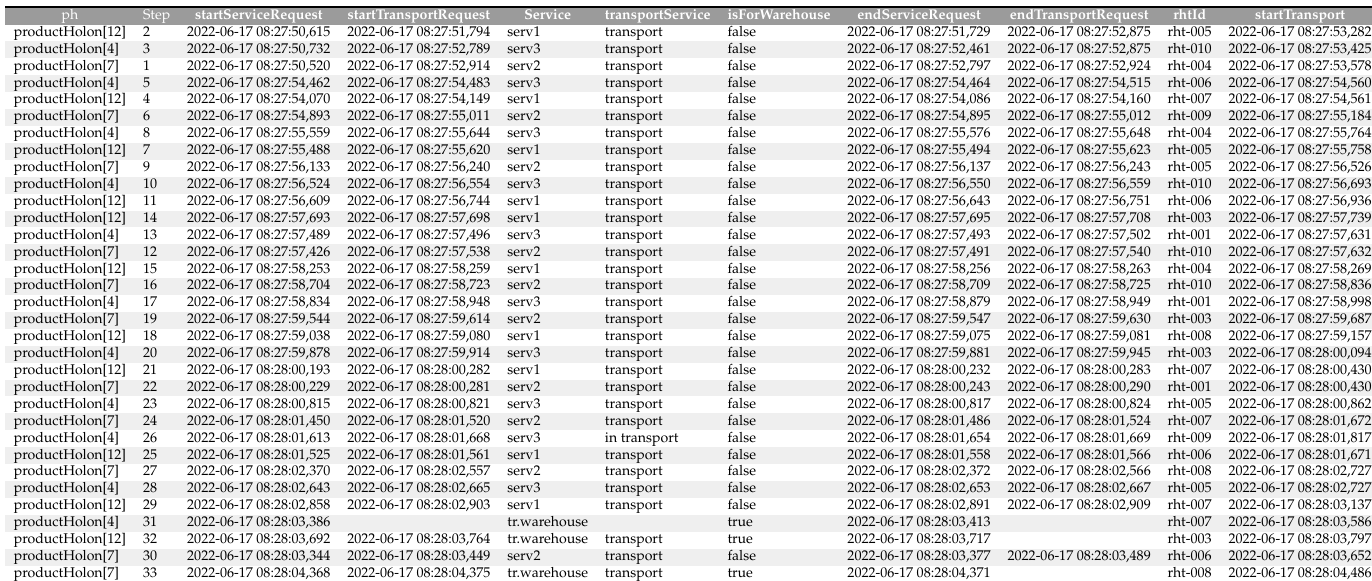
Table 3. Example of file content with simulation execution